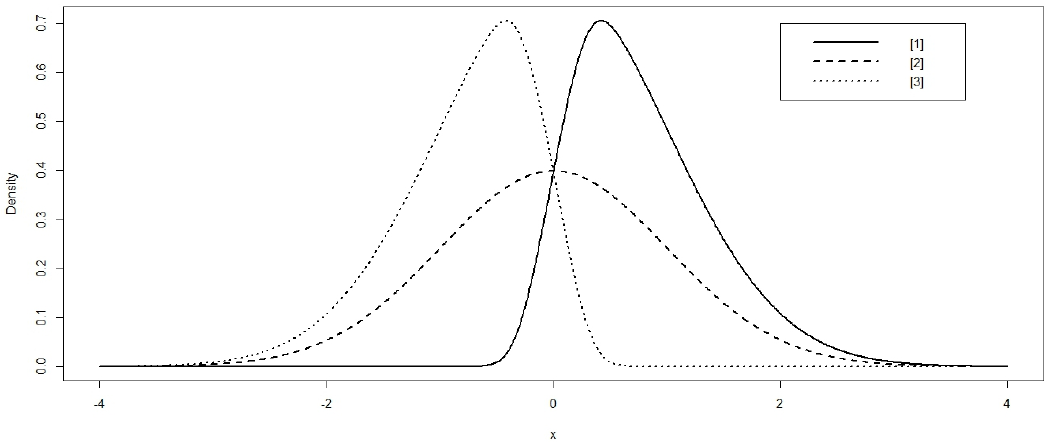
Figure 1. The skew normal-generalized logistic distribution (Skew Normal-GL) using the following parameter values: [1] A = 6, B = 10.8 and p = 2; [2] A = 0, B = 0 and p = 3; [3] A = − 6, B = − 10.8 and p =